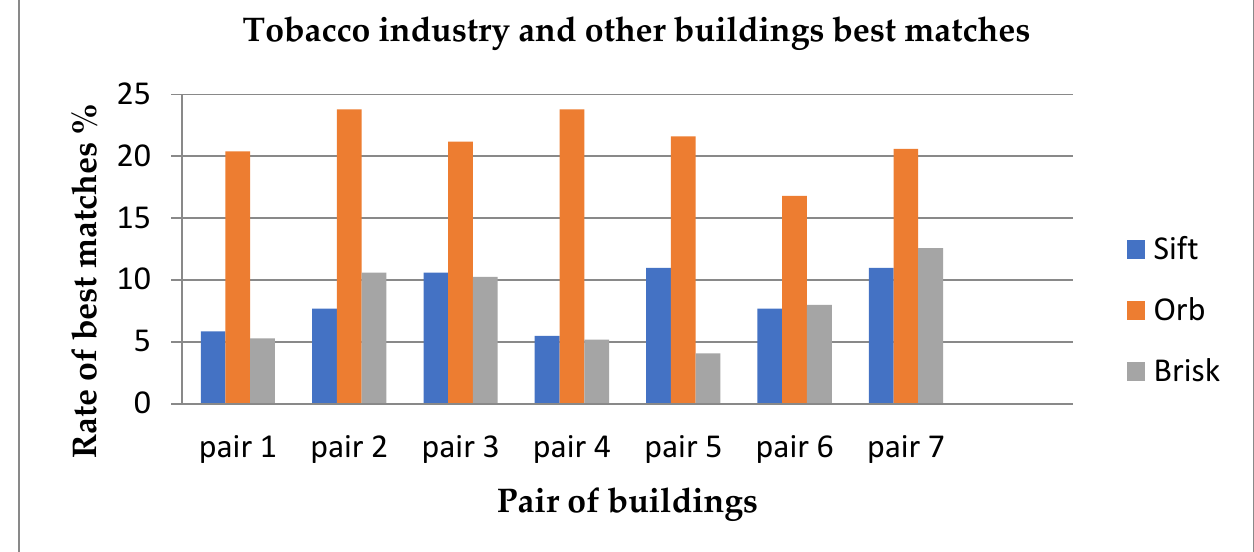
Figure 19. Rate of the best matches of different buildings by algorithms.